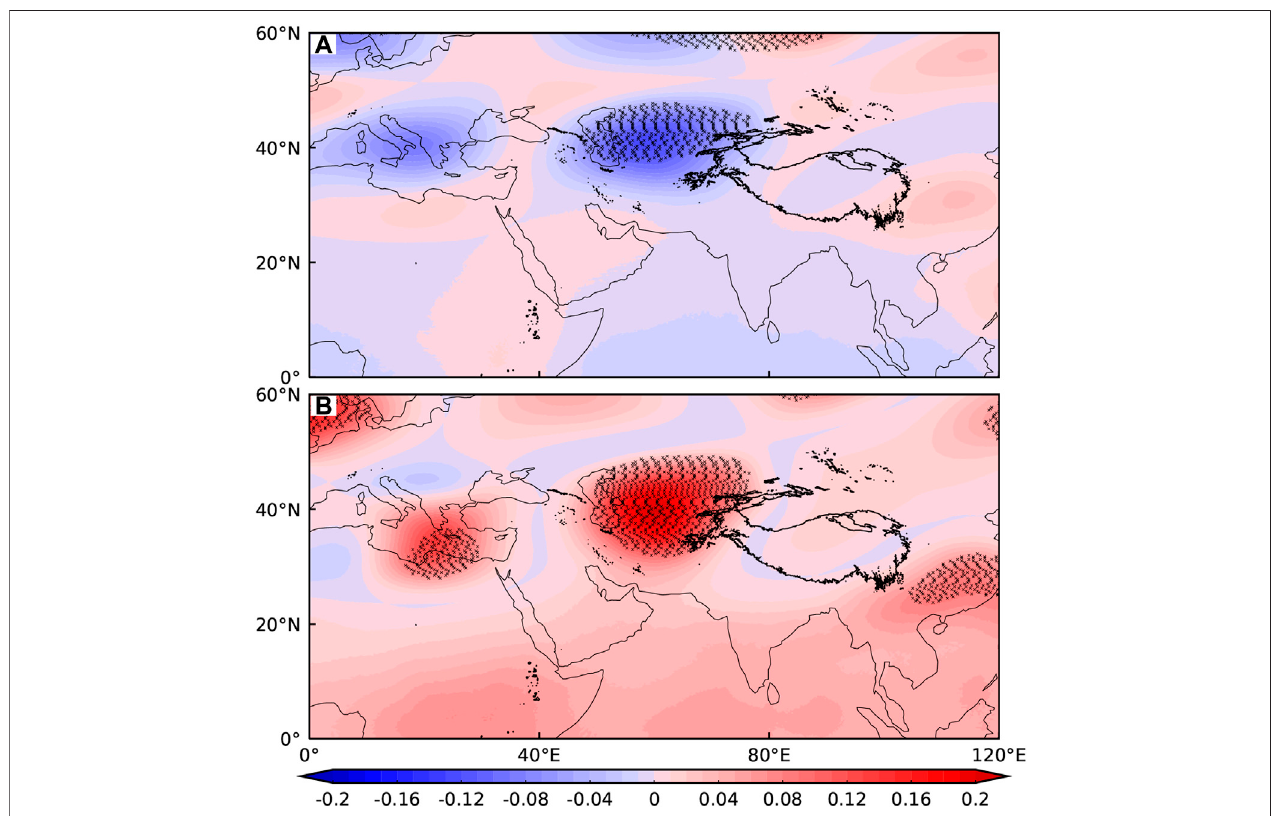
FIGURE8| Information fl owbetween200 hPageopotentialheightandtheTOI(shading).Blackdotsrepresentsigni fi cantinformation fl owsat the90%con fi dence level; (A) T 1 → 2 : 200 hPageopotential height → TOI and (B) T 2 → 1 : TOI → 200 hPageopotential height .